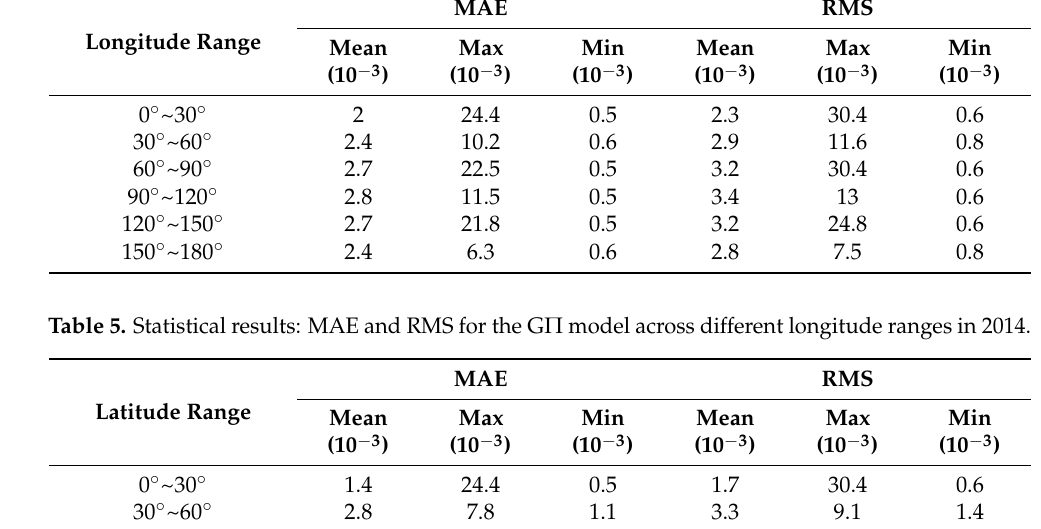
Longitude Range